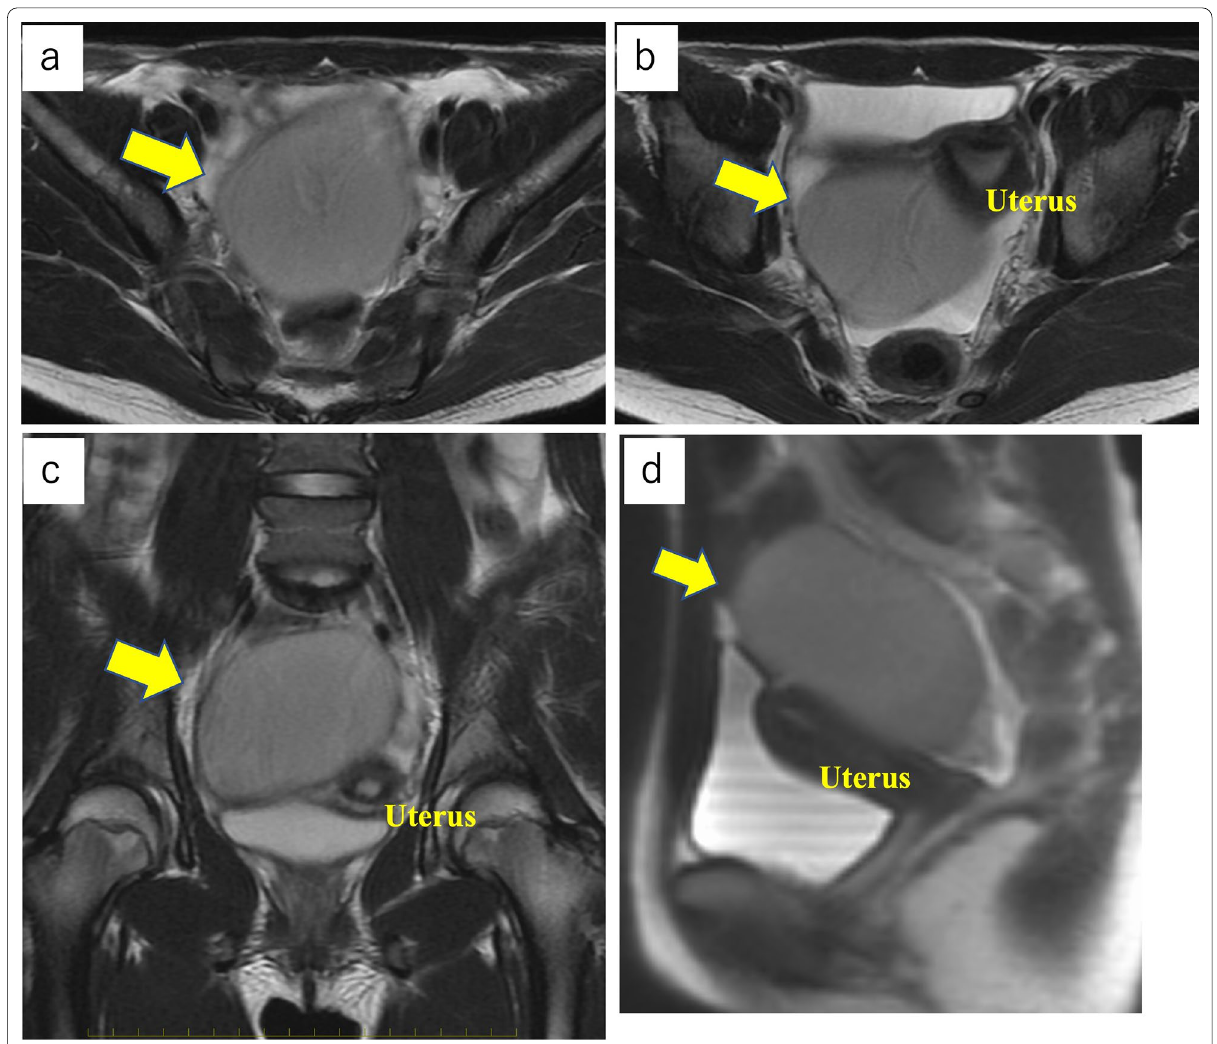
Fig. 1 Preoperative pelvic magnetic resonance imaging. Preoperative images show a tumor (yellow arrow) that was a cystic mass measuring 90 65 mm with a smooth margin and homogeneous signal intensity on the right dorsal side of the uterus ( a – d ). Coronal image ( c ), sagittal × image ( d ). T1-weighted images present slightly higher signals than those of water, and T2-weighted images show low signals. No apparent communication was found between the cyst and the intestinal